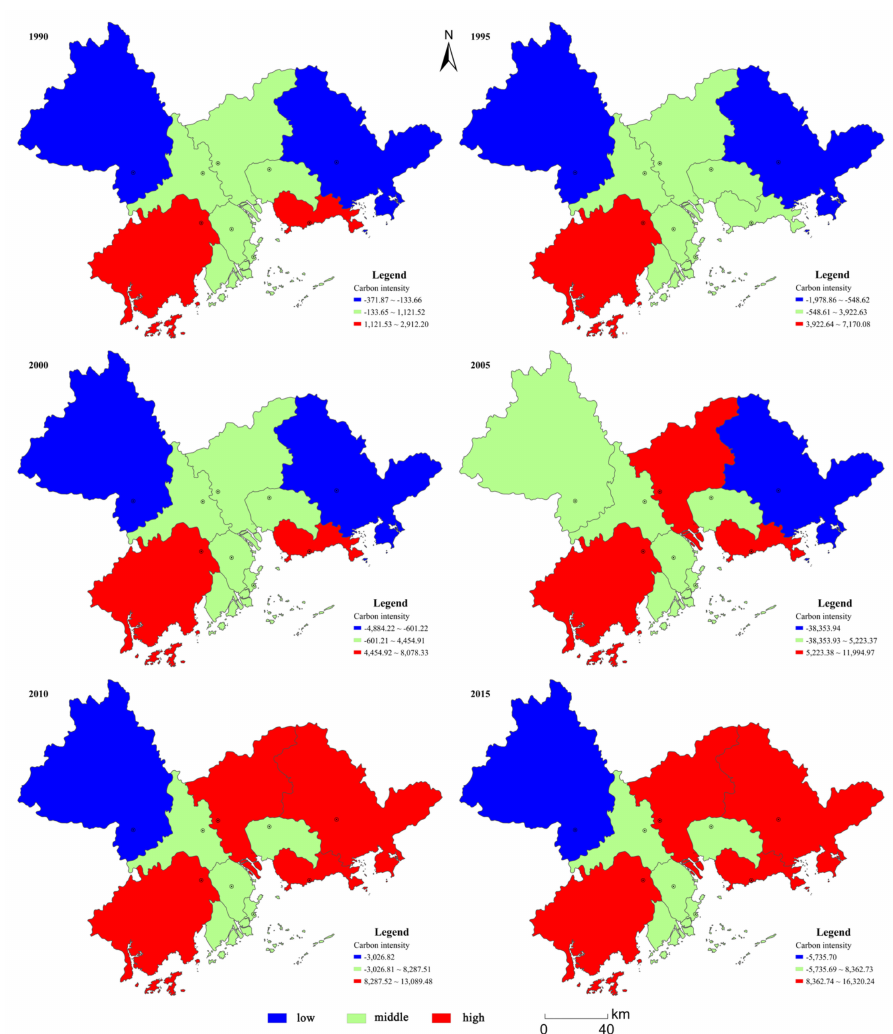
Figure 6. The spatial distribution of dynamic carbon emission intensity in the